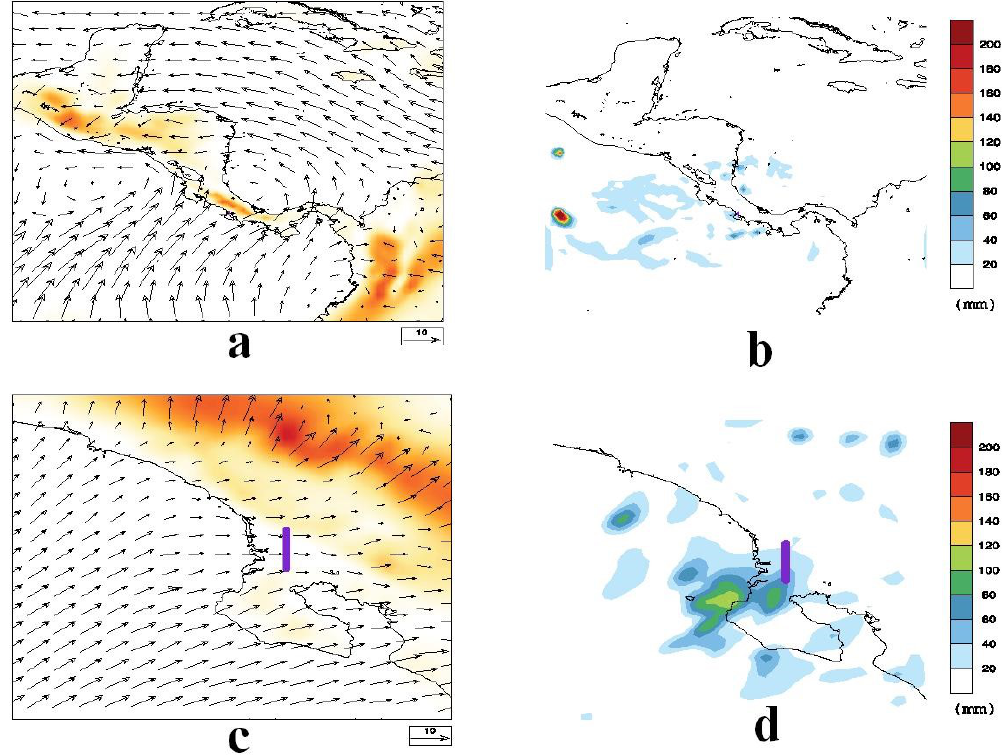
Fig. 5. MM5 mean simulations for 27 May 2008 from 06-18Z of tropical depression that conducted to the formation of tropical storm Alma for (a) wind vector at 925hPa at a domain with a resolution of 30km; (b) accumulated precipitation at a domain with a resolution of 30km; (c) same as (a) but for a domain of 3.3km resolution; and (d) same as (b) but for a domain with of 3.3km resolution. The purple vertical solid line in (c) and (d) denotes the region near the Diquis Delta in southern Costa Rica, home of the archeological site of the stone